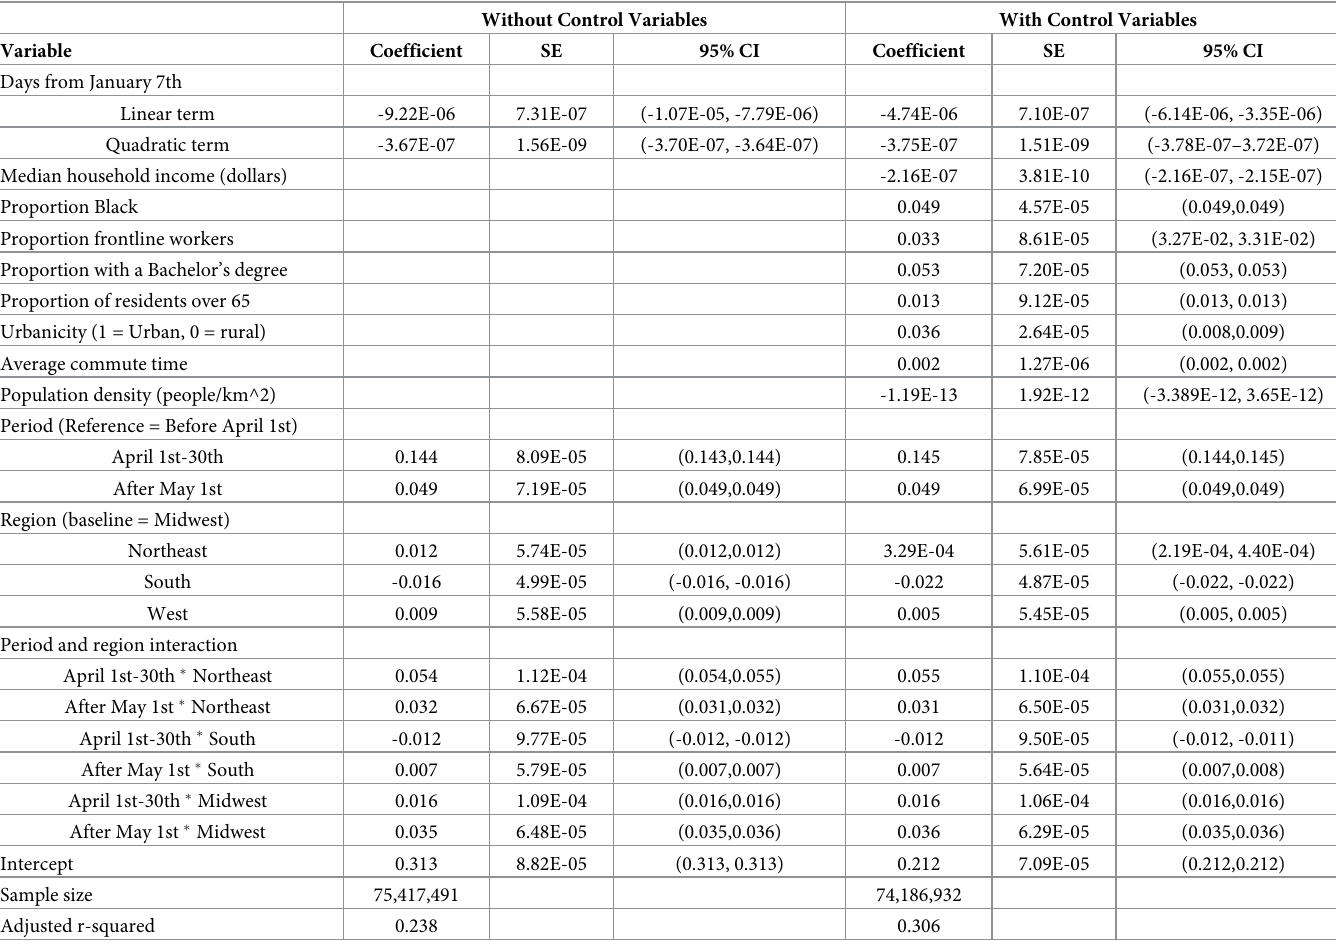
Table 1. Regional disparities in physical distancing. Without Control Variables With Control